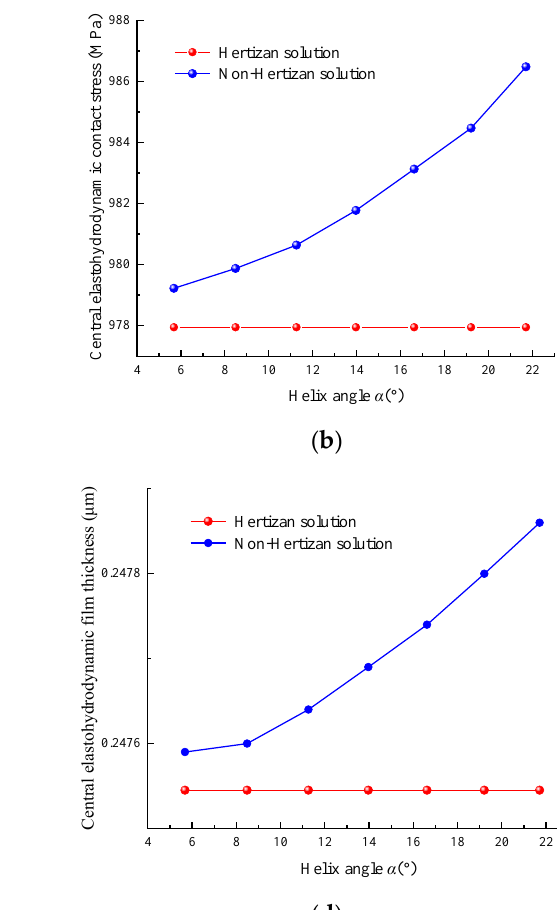
Figure 10. Elastohydrodynamic characteristics using the non-Hertzian contact stress calculation method. ( a ) Elastohydro- dynamic contact stress distribution. ( b ) Film thickness distribution.